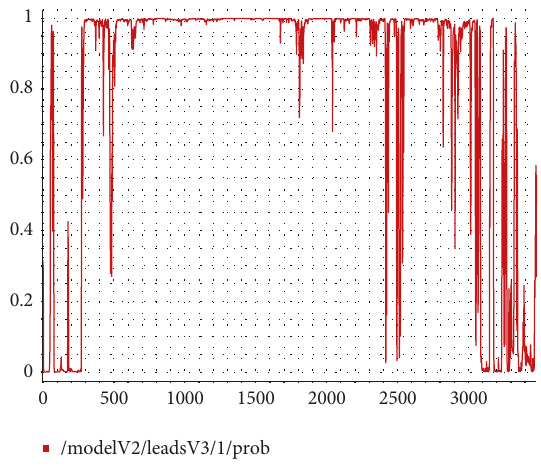
Figure 58: T2D3 temperatures.